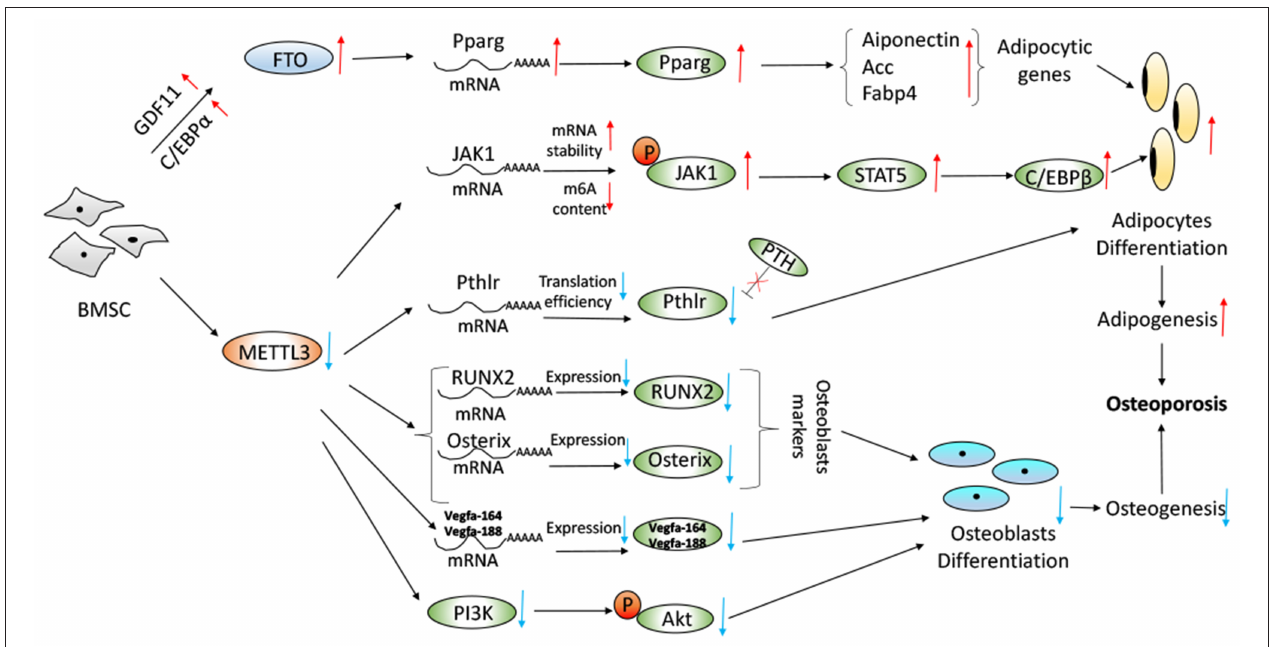
FIGURE 2 | Proposed model depicting regulation and role of METTL3 and FTO in BMSC adipogenesis and osteogenesis with regard to osteoporosis. Working model of the mechanism of METTL3 knockdown increased JAK1/STAT5/C/EBPb pathway, decreased PTH/Pth1r signaling axis, decreased expression of RUNX2, Osterix, and Vegfa and decreased PI3K-Akt signaling pathway. Overexpression of FTO in a GDF11-C/EBP α -dependent mechanism resulted in increase of the Pparg mRNA and the promotion of